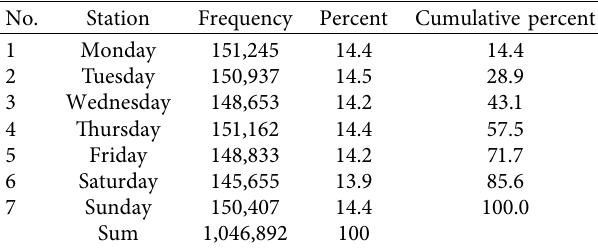
Table 5: Percentage of date in this data.